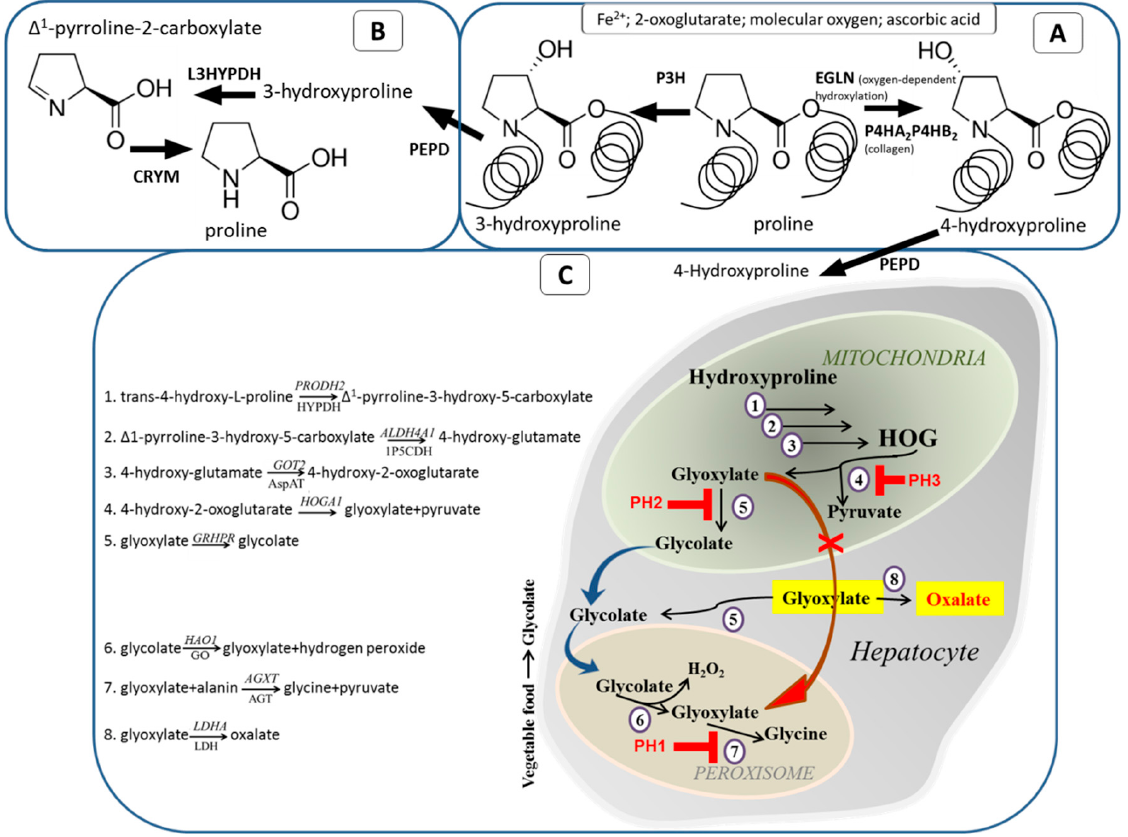
Figure 1. Schematic representation of proline hydroxylation ( A ), catabolism of 3-hydroxyproline ( B ), and 4-hydroxyproline ( C ). Gene designation in italic; protein designation (if different) in regular. PH1, PH2, PH3-types of primary hyperoxaluria.